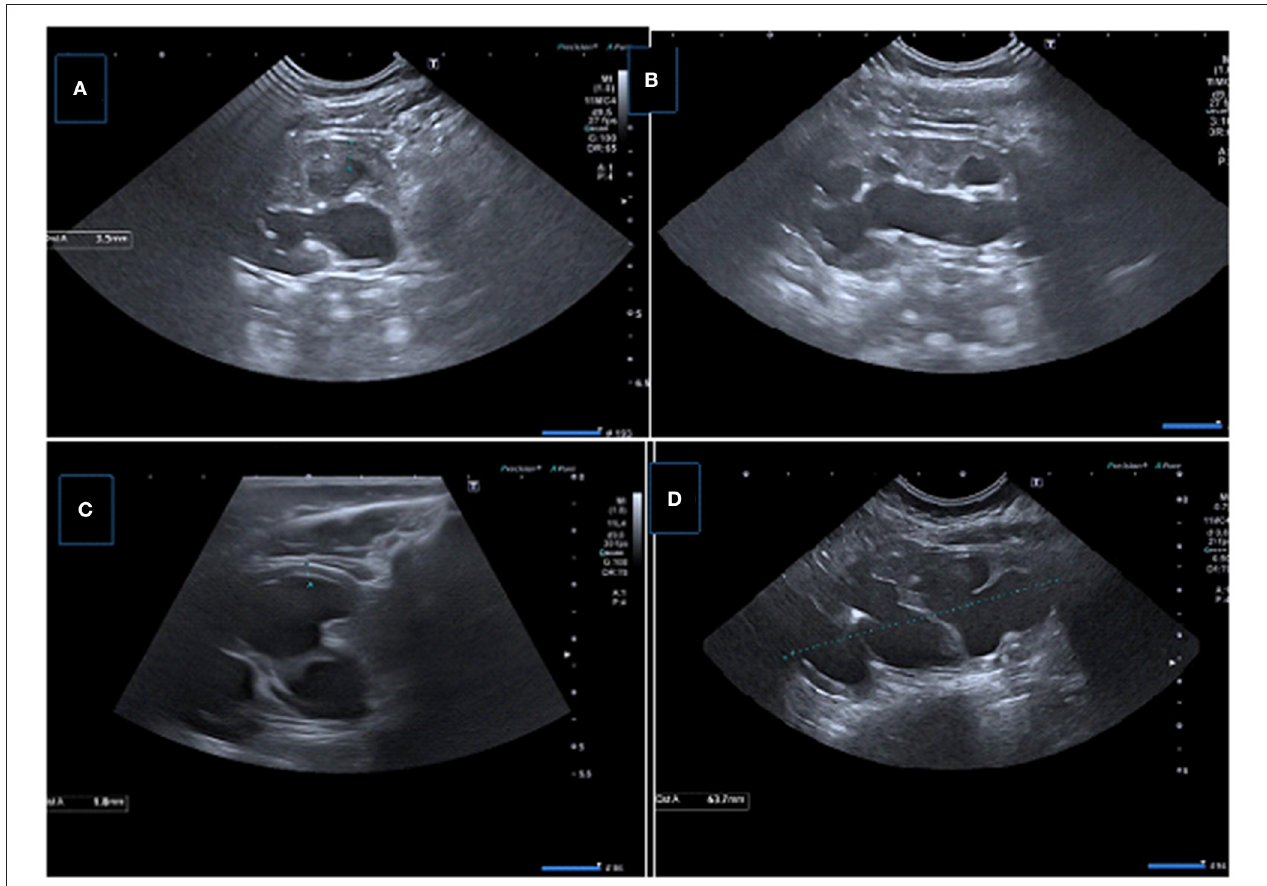
FIGURE 6 | Two consecutive US examinations in a 6-month-old girl with UPJ obstruction. (A,B) Baseline US images demonstrate decreased parenchymal thickness with pelvicalyceal dilatation. (C,D) Control (2 months later) US images showing significant decrease in renal parenchymal thickness with worsening pelvicalyceal dilatation. A new small echogenic focus suggesting microlithiasis is also